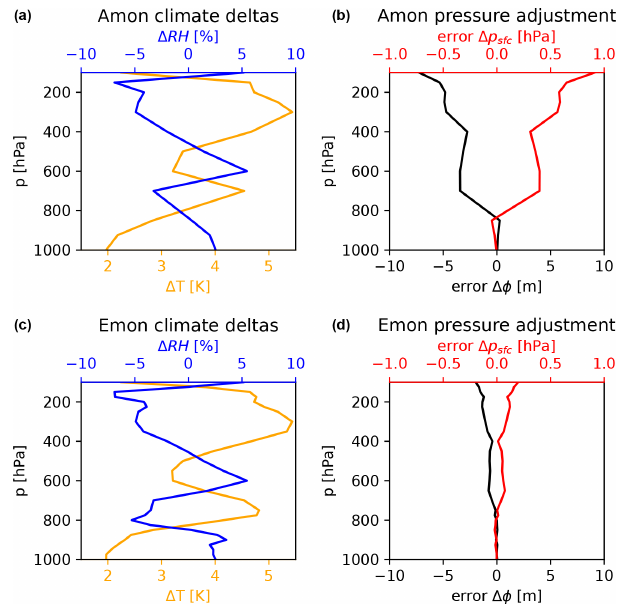
Figure 5. Illustration of the pressure adjustment using AMON (a, b) and EMON (c, d) pressure level data with 19 and 27 pressure levels, respectively. The analysis is done for a 2 ◦ × 2 ◦ box over the subtropical South Atlantic at a particular point in time. Panels (a) and (a) show (cid:49)T and (cid:49) RH, and panels (a) and (d) show the integra- tion error in (cid:49)φ when integrated from the surface (sfc) to pressure p and the error in (cid:49)p sfc resulting from the pressure adjustment for a given reference pressure level p ref ( y axis). The adjustment based on AMON data has large uncertainties (error in (cid:49)p sfc ) for p ref < 850hPa due to the pronounced trade-wind inversion. Further information about the data used and the error computation is given in Table